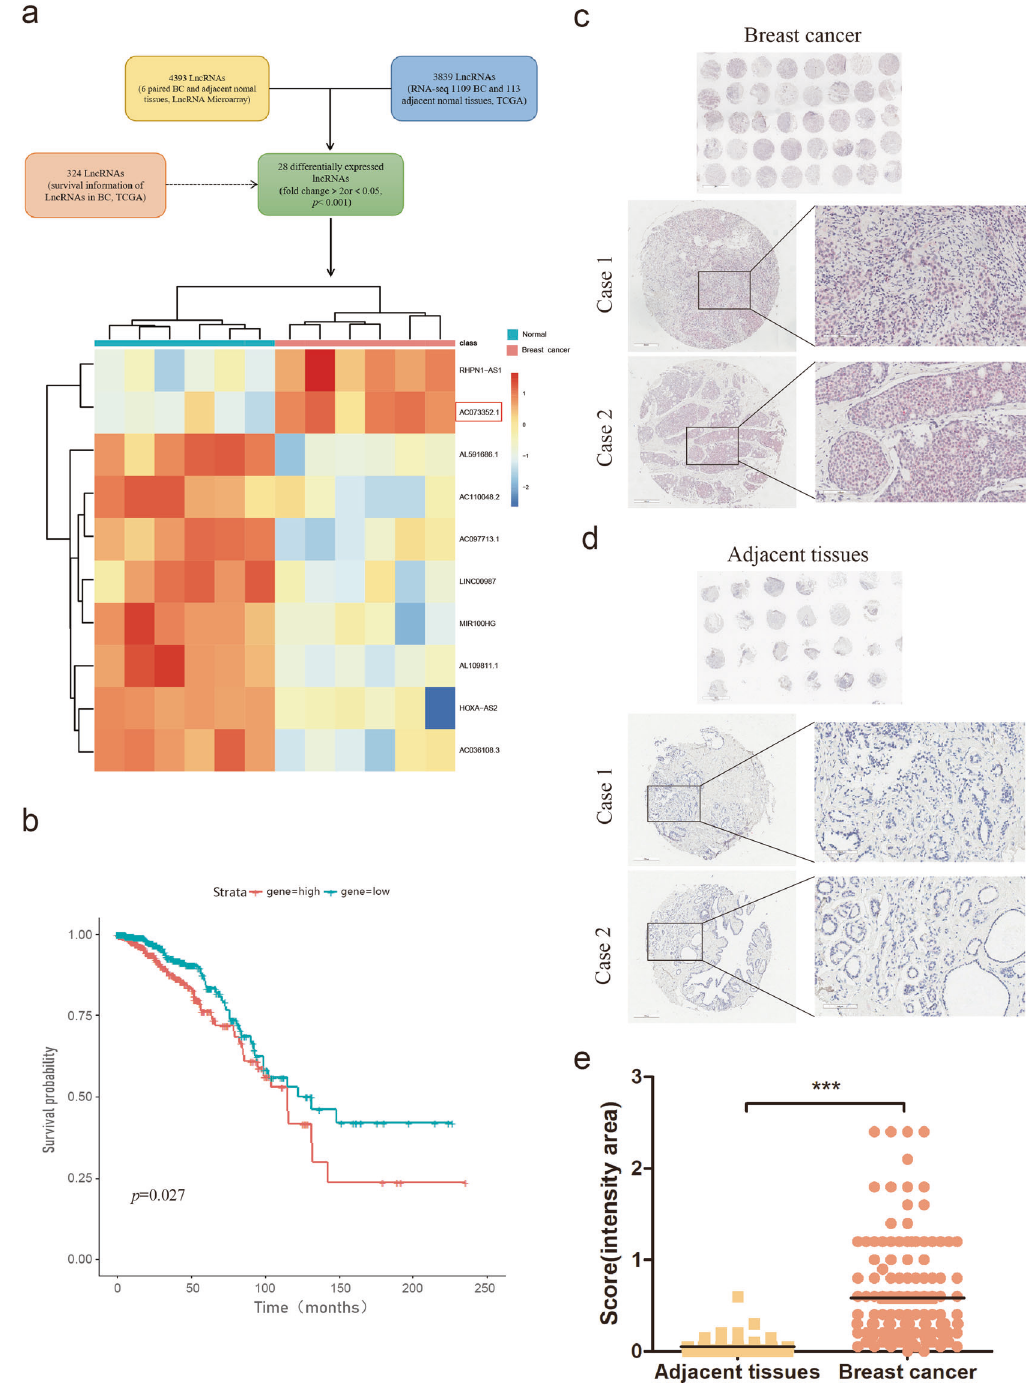
Fig. 1 AC073352.1 expression is upregulated and associated with poor outcomes in BC. a A fl owchart showing the selection of lncRNA AC073352.1 from the LncRNA microarray and TCGA database in BC. A heatmap representation of 10 overlapping lncRNA for gene expression pro fi les of 6 BC tissues and paired adjacent normal tissues in LncRNA microarray (fold change >2 or <0.5, p < 0.001). b Kaplan – Meier analyses of the correlation between AC073352.1 RNA levels and the overall survival rate of patients with BC, using TCGA data. Patients were strati fi ed for the analysis using the median. c – e ISH analysis detecting AC073352.1 expression (red) in BC tissue ( n = 137) and adjacent normal tissues ( n = 67). Representative images from c two BC cases and d adja c ent normal tissue are shown (magni fi cation: ×200). e Statistical analysis was assess e d by t test. *** p value <